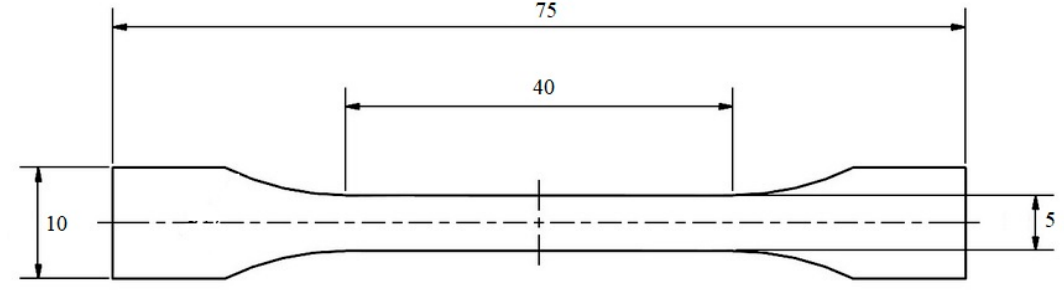
Figure 4. Dog bones used for tensile tests (dimension in Figure 4. dog bones used for tensile tests (dimension in mm). Figure 4. dog bones used for tensile tests (dimension in mm). Figure 4. dog bones used for tensile tests (dimension in mm).